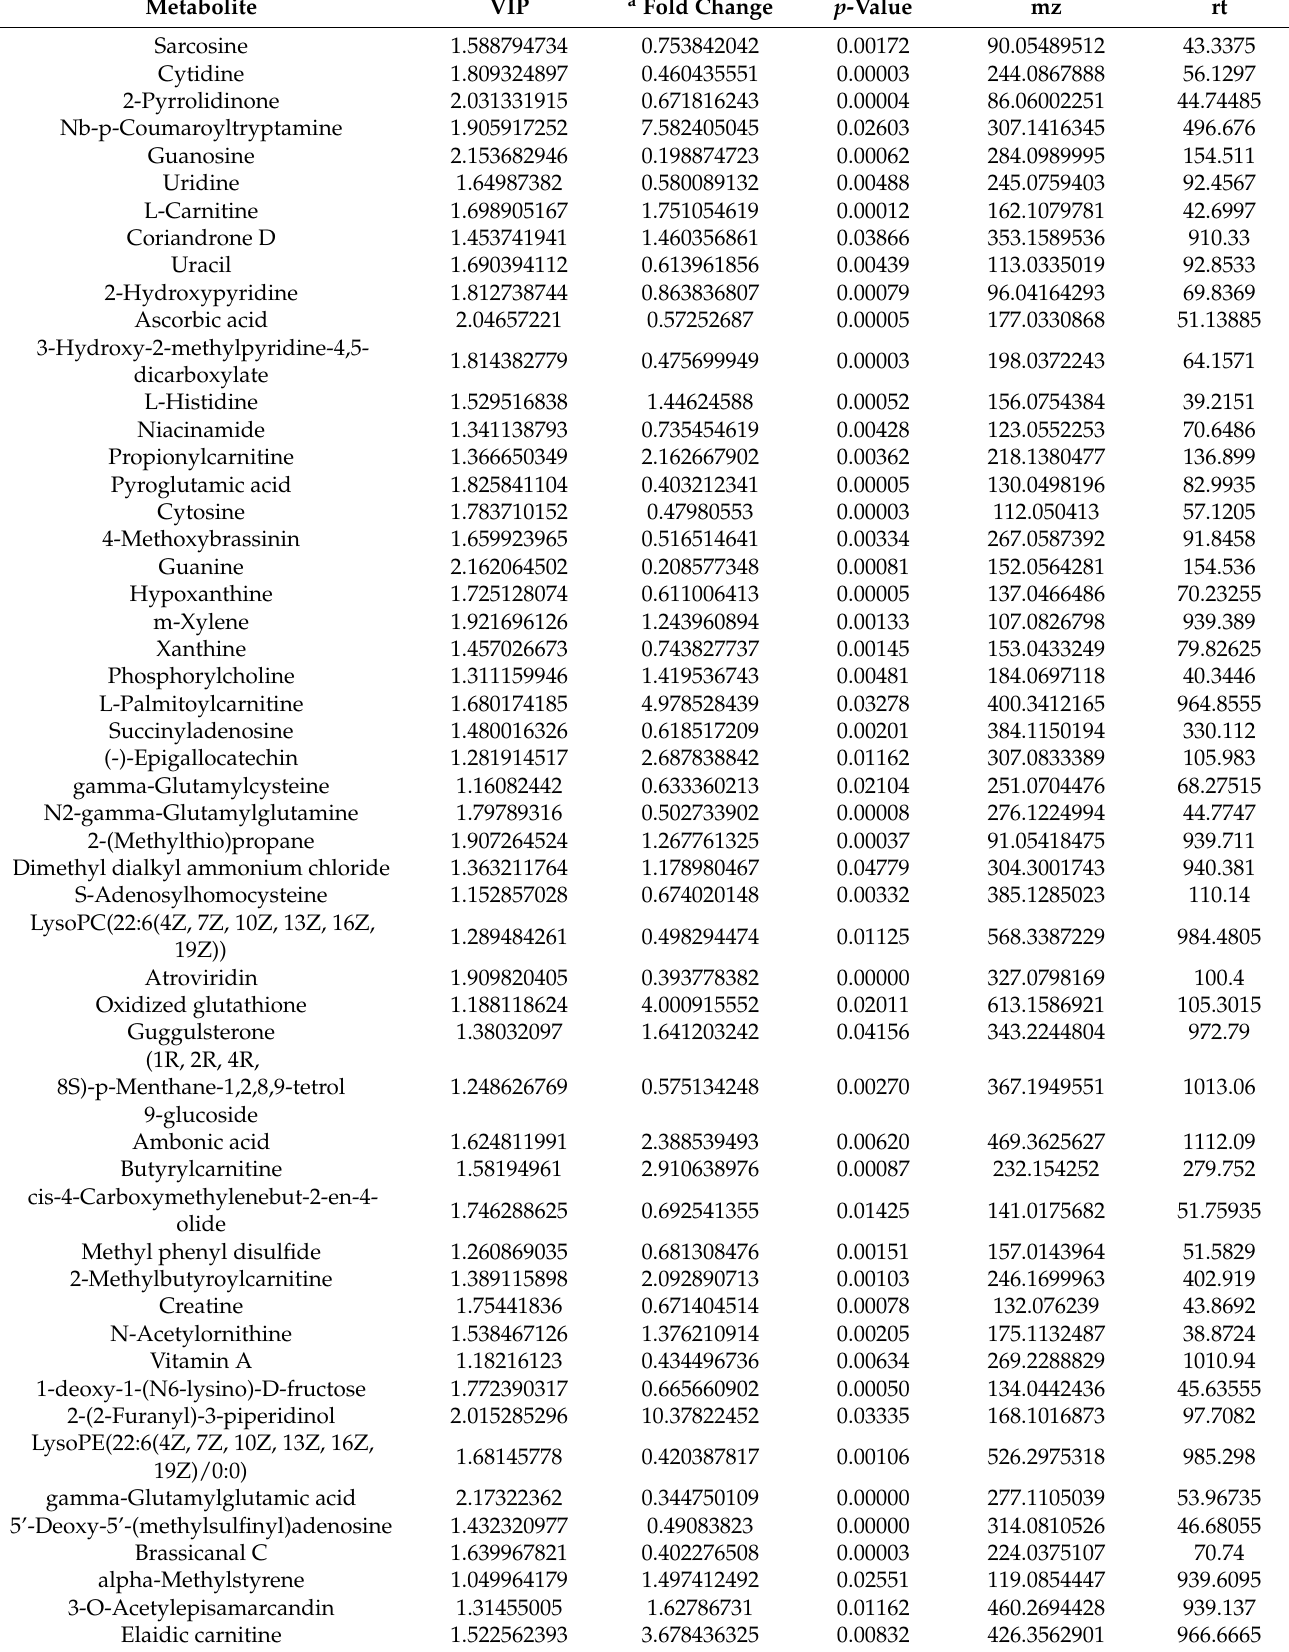
Table 1. Significantly altered metabolites under positive mode by untargeted